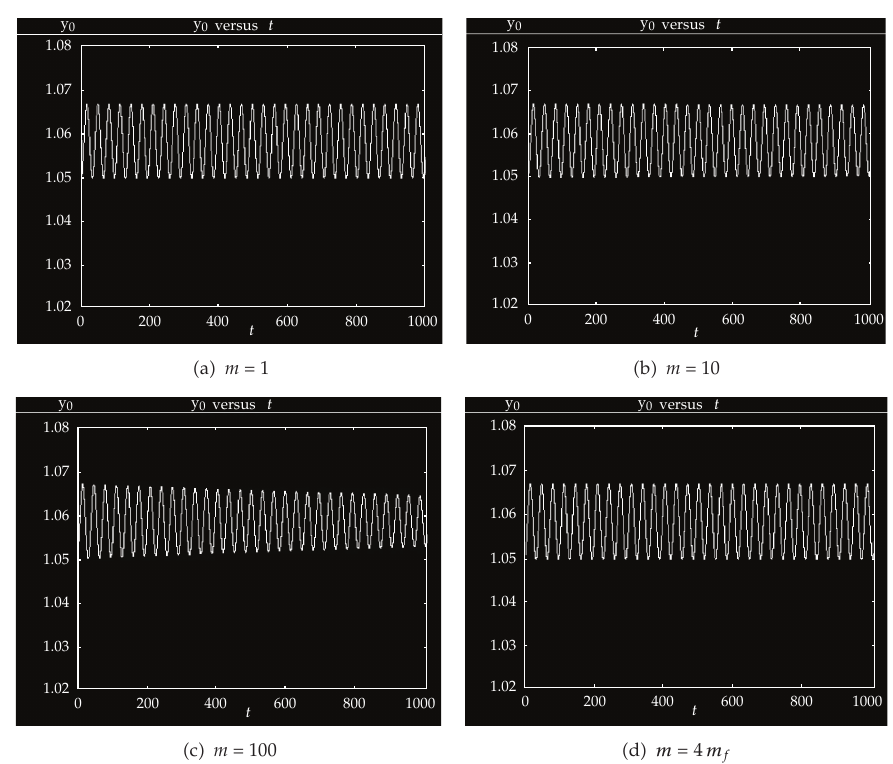
Figure 5: Stretch ratio for viscoelastic model with varying m